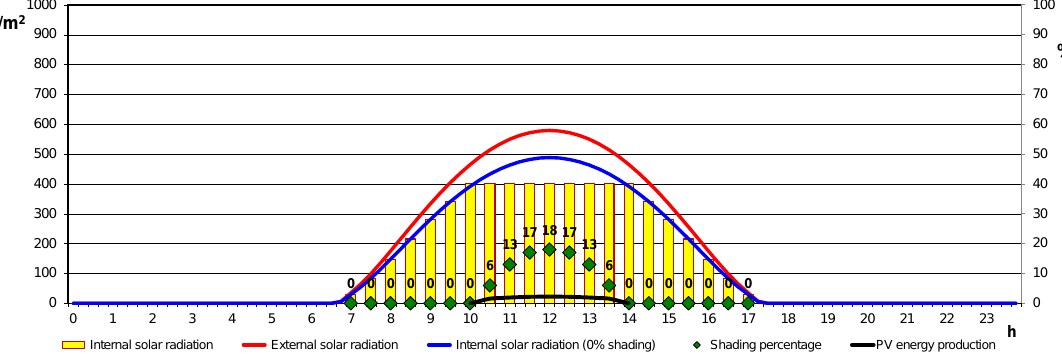
Figure 12. Daily trend of shading percentages so that the internal solar radiation is lower than or equal to the set limit on February 21.